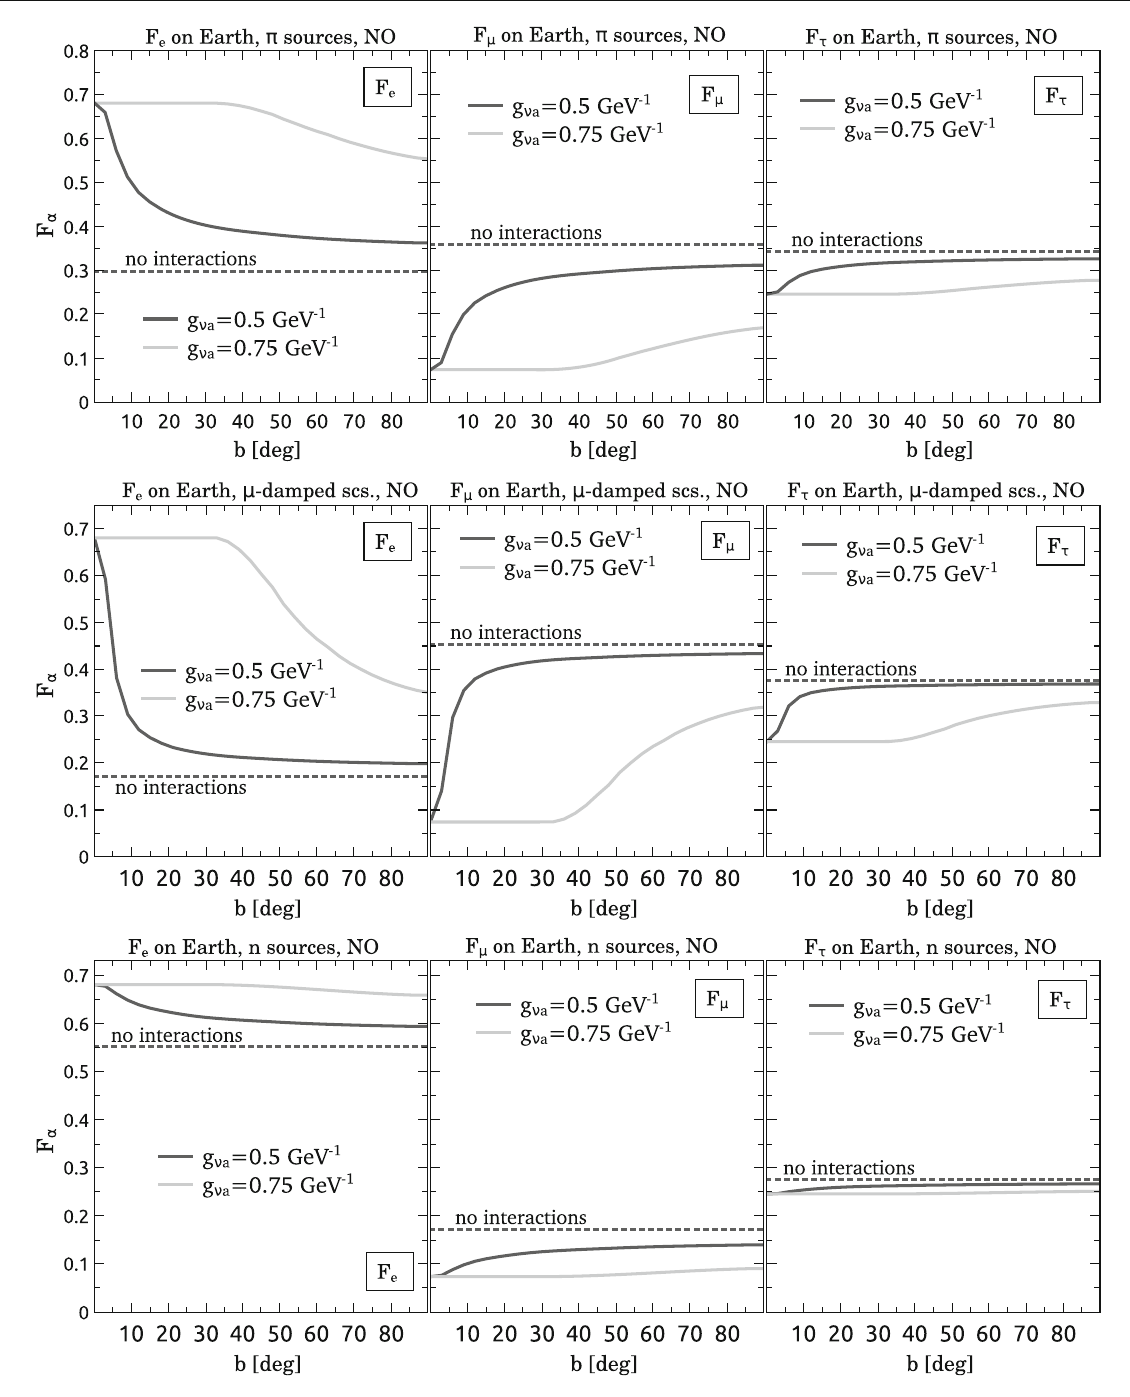
Fig. 9 Flavor ratios of the integrated fluxes in the NO case as a func- tion of the galactic latitude b corresponding to the arrival direction, for a fixed galactic longitude l = 0 ◦ . The electron, muon, and tau fla-